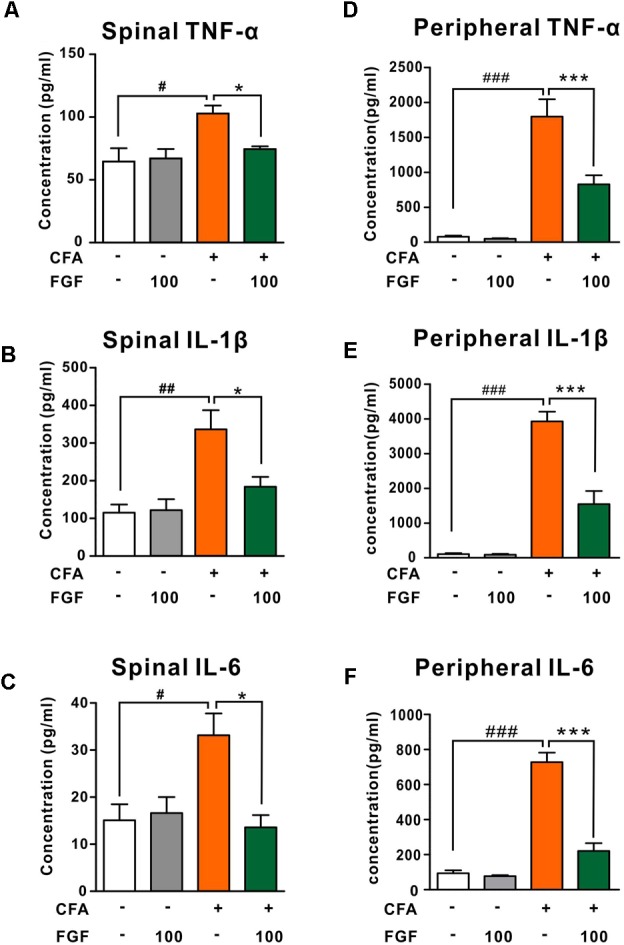
FGF down-regulated TNF-α, IL-1β and IL-6 levels in the lumbar spinal cord in the spinal cord and the paw tissue of CFA-inflamed mice. The levels of TNF-α, IL-1β, and IL-6 in the lumbar spinal cord (A–C) and the inflamed paw tissue (D–F) were examined by ELISA. #, ##, ### vs. controls and ∗, ∗∗, ∗∗∗ vs. CFA-treated animals. One symbol, p < 0.05; two symbols, p < 0.01. One-way ANOVA and Bonferroni multiple comparison tests as post hoc analyses were used (n = 7–9 mice per group).